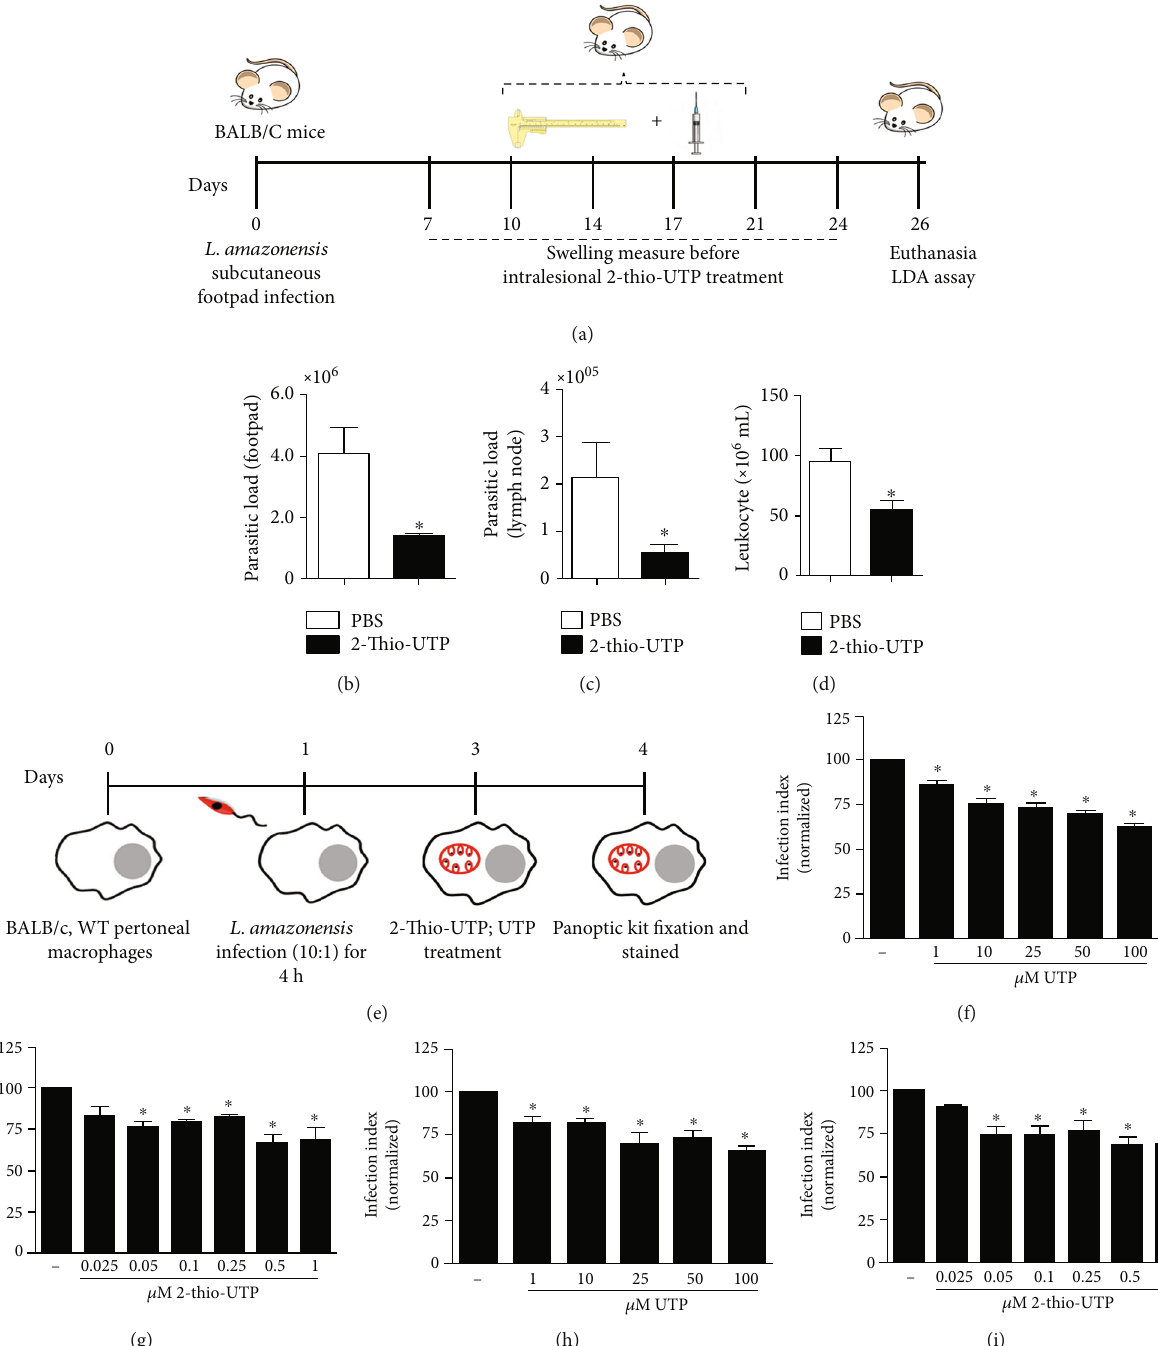
Figure 1: P2Y R selective agonist 2-thio-UTP improves host resistance against L. amazonensis . (a) Schematics showing the animal model of in vivo 2 experiments. BALB/c mice ( n = 6/group ) were subcutaneously injected in the footpad with 10 6 promastigotes ( L. amazonensis at stationary phase). From 7 days postinfection (d.p.i.), mice were treated with 10 μ M 2-thio-UTP in 20 μ L PBS and injected into the infected footpad twice a week for 3 weeks (six doses). (b – d) Animals were euthanized 26d.p.i., and the footpads and popliteal lymph nodes were removed and used for further analysis. (b) Parasitic loads in the footpads and lymph nodes (c) were determined using a limiting dilution assay (LDA). (d) Leukocyte numbers from popliteal lymph nodes. (e) Schematics showing the design of in vitro experiments. BALB/c (f, g) and C57Bl/6 (WT) (h, i) macrophages infected for 48h were treated for 30min with UTP (1 – 100 μ M UTP) (f – h) or 2-thio-UTP (0.025 – 1 μ M) (g – i). After 30h, cells were fi xed, stained with the panoptic kit, and observed with light microscopy. The e ff ect of treatments on infection was quanti fi ed by determining the “ infection index ” ð % of infection × number of amastigotes/total number of cells Þ /100 ; normalized to the untreated), by direct counting under the light microscope. Data represent mean ± SEM of three independent experiments performed in triplicate, with pools of cells from four animals each experiment. ∗ P < 0 : 05 relative to the untreated group (one-way analysis of variance followed by Tukey ’ s